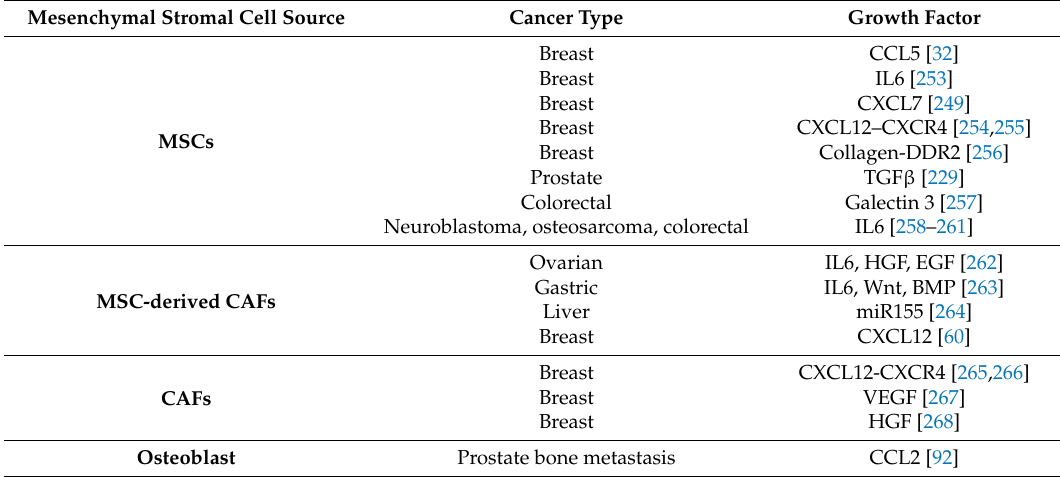
Table 2. Mesenchymal stromal cell-derived factors involved in tumor